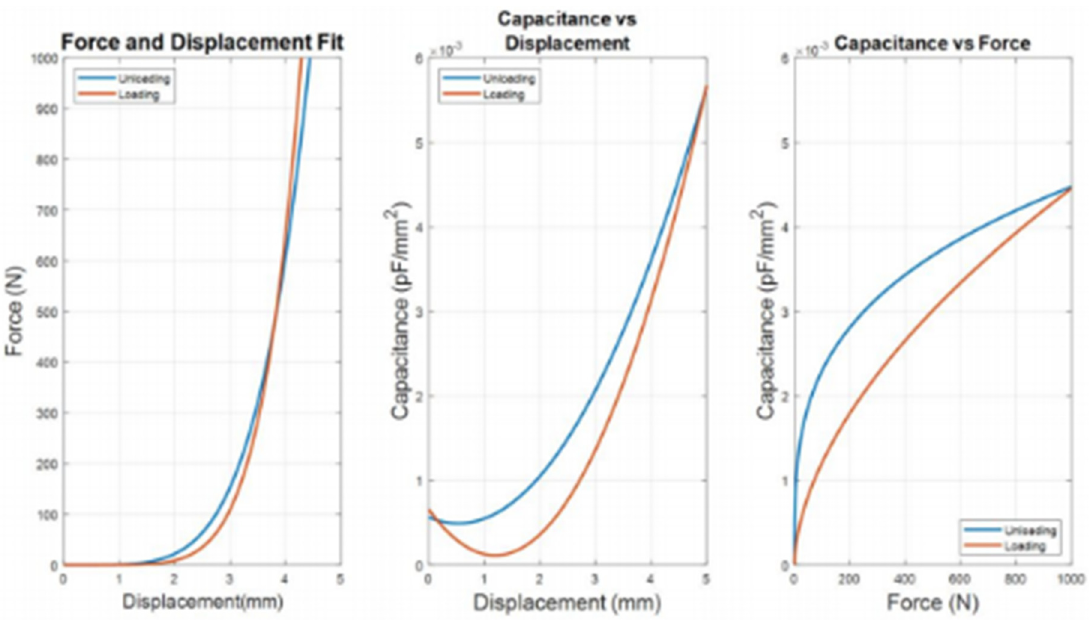
Figure 25. Calibration Curves for different data sets.